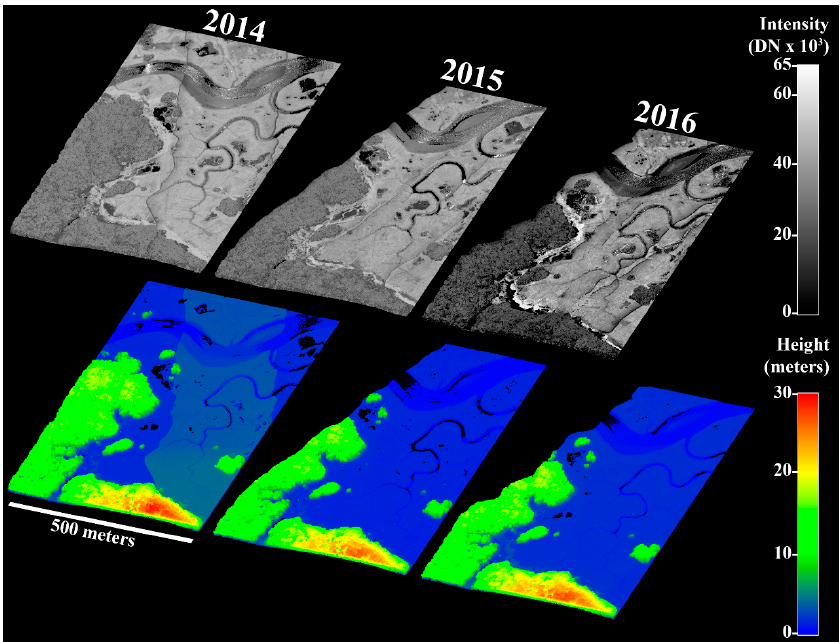
Figure 2. Airborne lidar acquisitions for 2014–2016 from NASA G-LiHT instrument package for the Plum Island (MA, USA) study site. The top row shows lidar returns colored by intensity (1550 nm wavelength). The bottom row shows lidar returns colored by height.